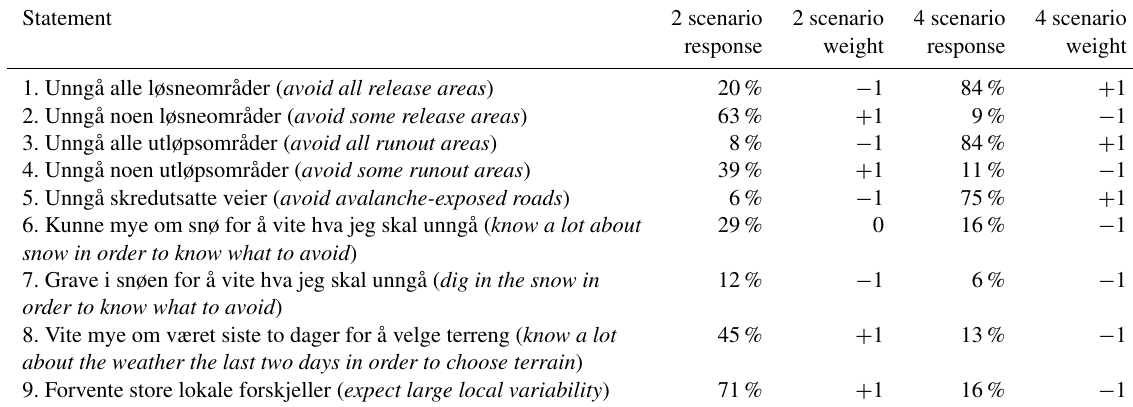
Table 3. Expert survey results (number of respondents selecting the statement, in %) and design weights established for a communication effectiveness